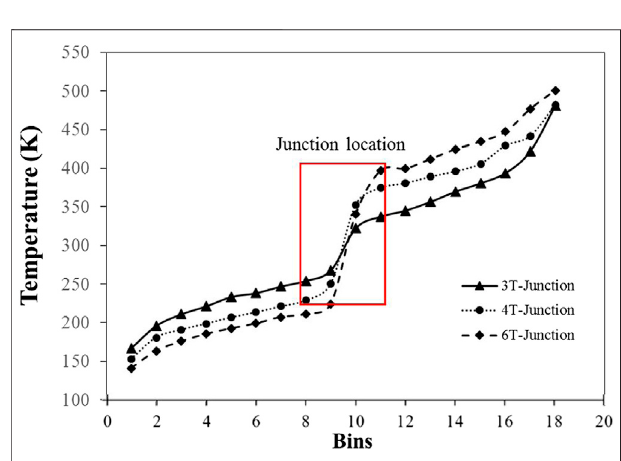
FIGURE 9 | Thermal gradient along the longitudinal direction of the